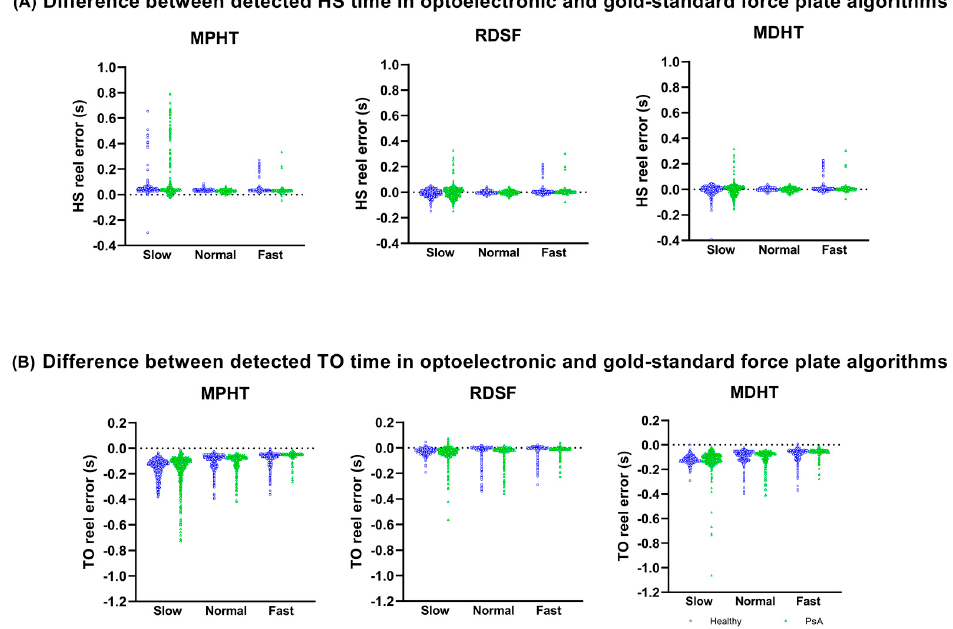
Figure 3. HS and TO accuracy for each step. ( A ) Difference in detected HS time between MoCap- based algorithms and GS at three walking speeds for healthy participants (blue circles) and PsA participants (green triangles). ( B ) Difference in TO times between MoCap-based and GS algorithms for slow, normal, and fast walking speed. Blue circles represent healthy participants, and green tri- angles represent PsA participants.